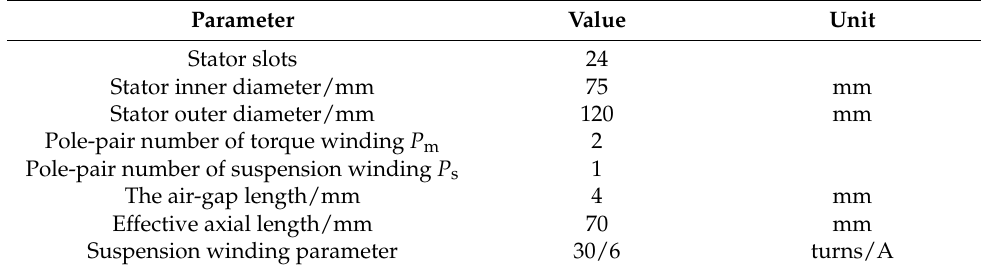
Table 1. Main parameters of bearingless PMSM.